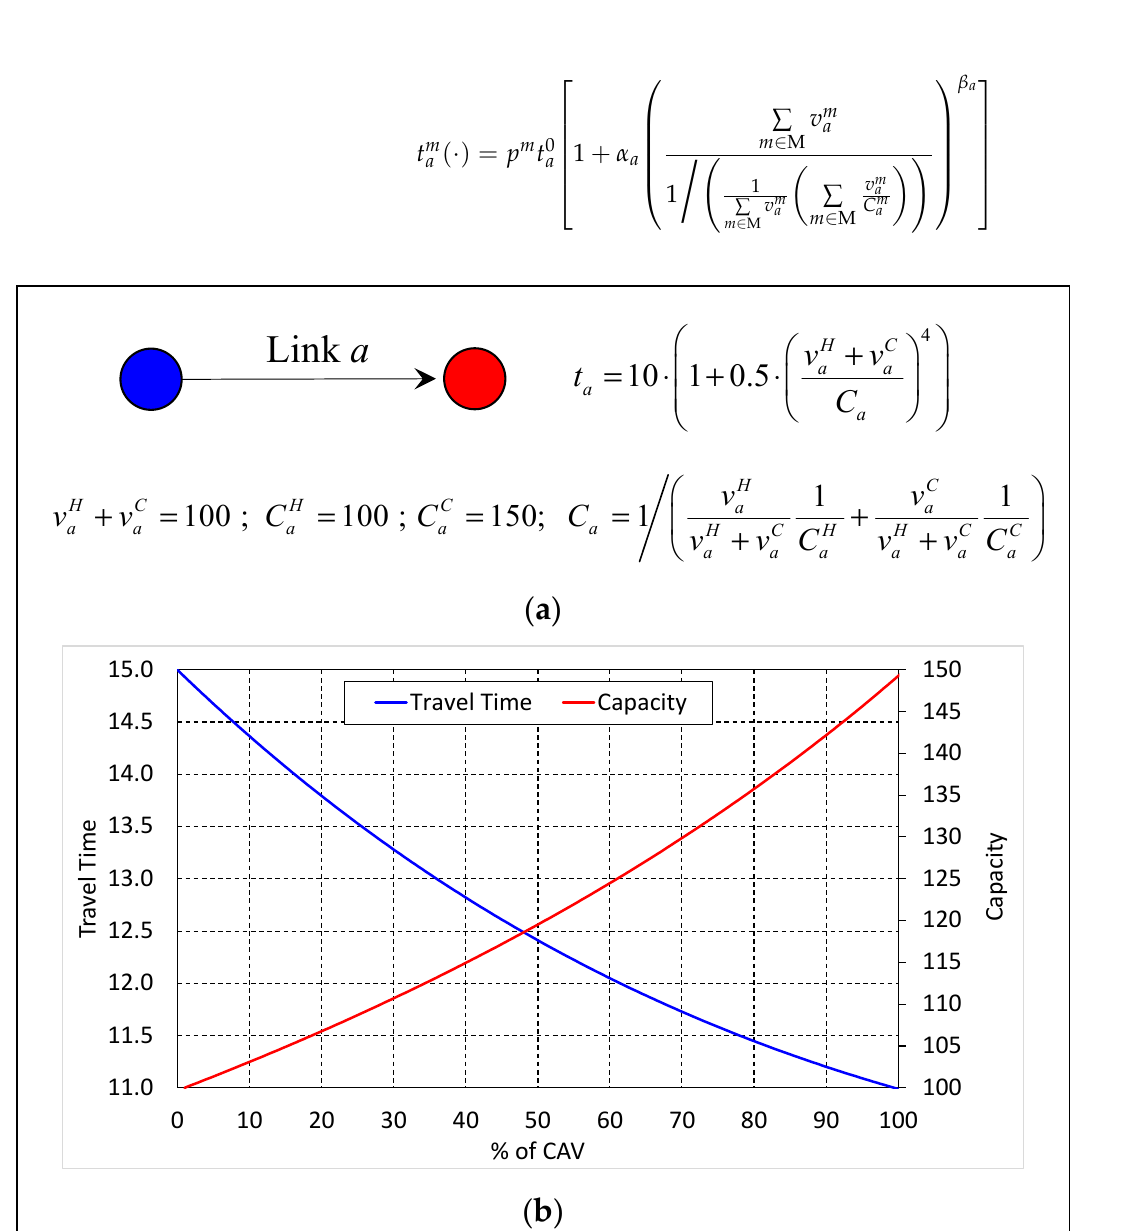
Figure 2. Graphical illustration of travel time and capacity change. ( a ) Link travel time function and parameters. ( b ) Travel time and capacity change as a function of the proportion of CAVs.